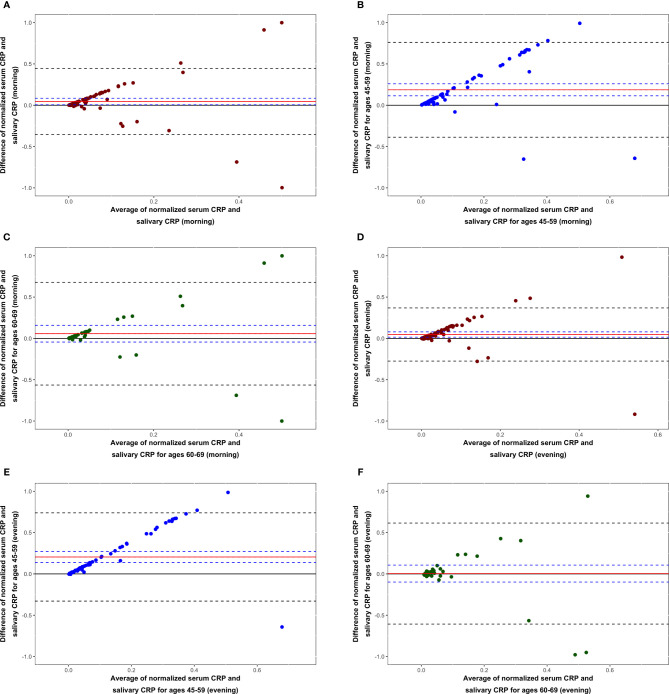
Bland–Altman graphs showing the level of agreement between serum C-reactive protein (CRP) and CRP in morning saliva for all participants (A), those aged 45–59 (B) and those aged 60–69 years (C). Bland–Altman graphs reflecting the level of agreement between serum CRP and CRP in evening saliva for all participants (D), those aged 45–59 (E) and those aged 60–69 years (F). Data are based on analysis of 99 morning and 97 evening samples. Interchangeability was only suggested among participants aged 60–69 years for morning (p=0.26) as well as evening (p=0.94) saliva.